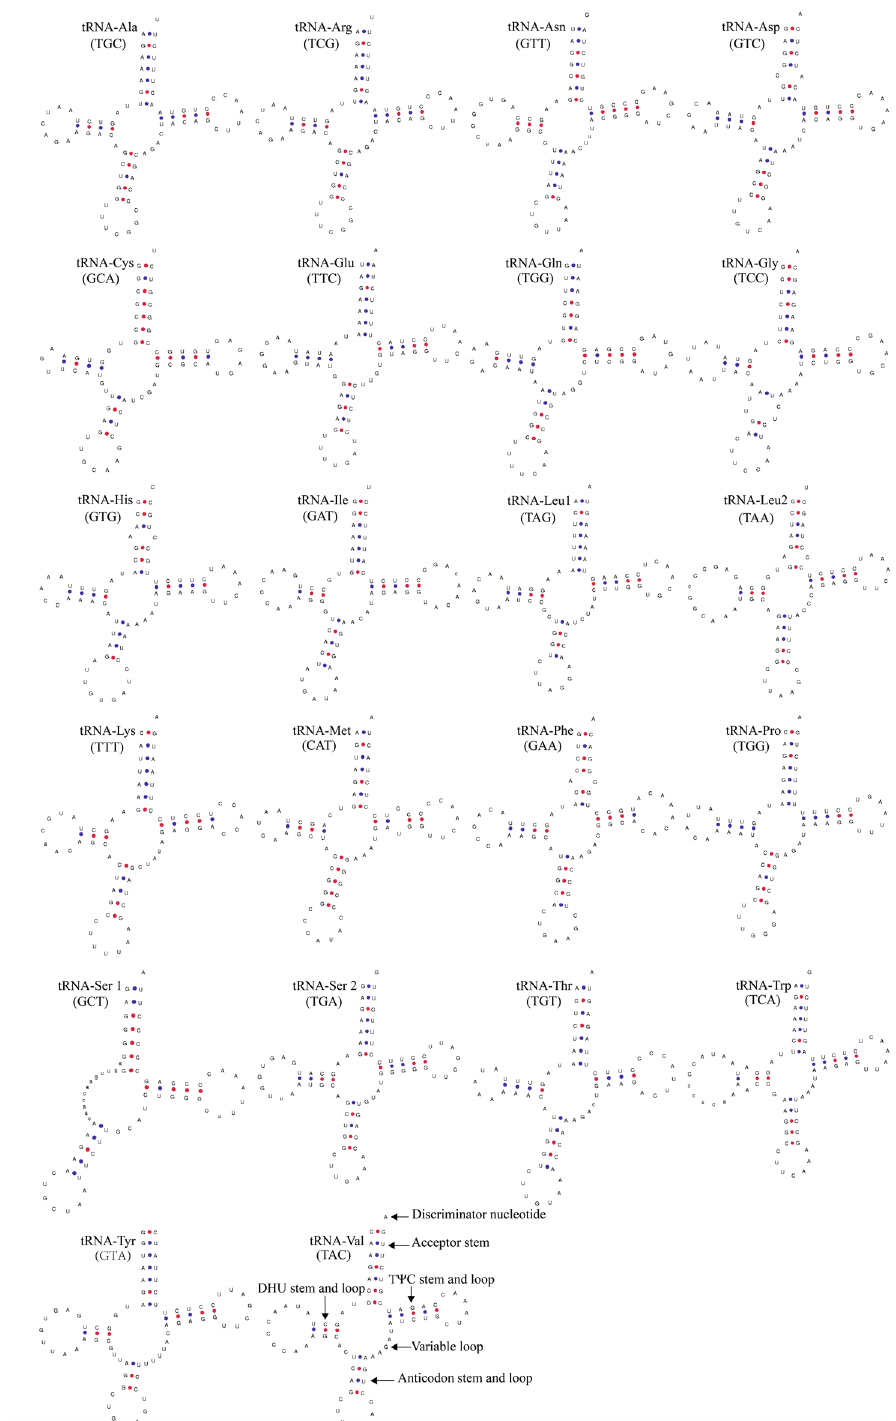
Figure 4. Secondary structures of Aythya baeri